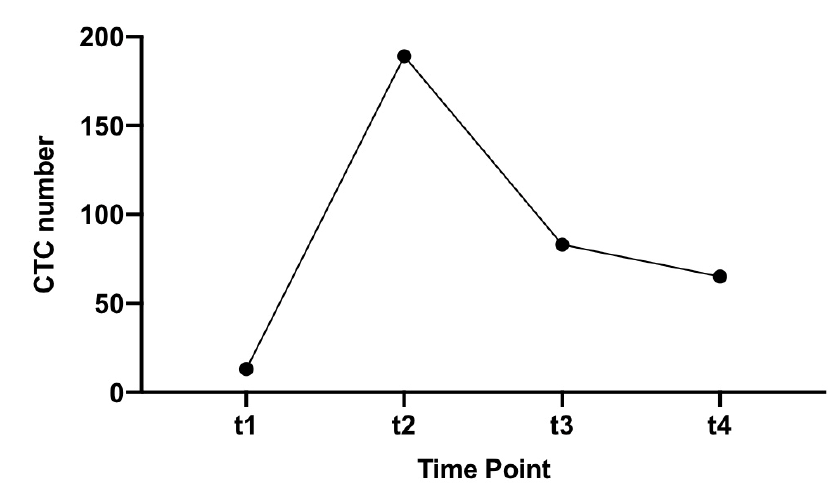
Figure 2. CTC number at different time points for patient S16 (stage IV, MSS CRC).